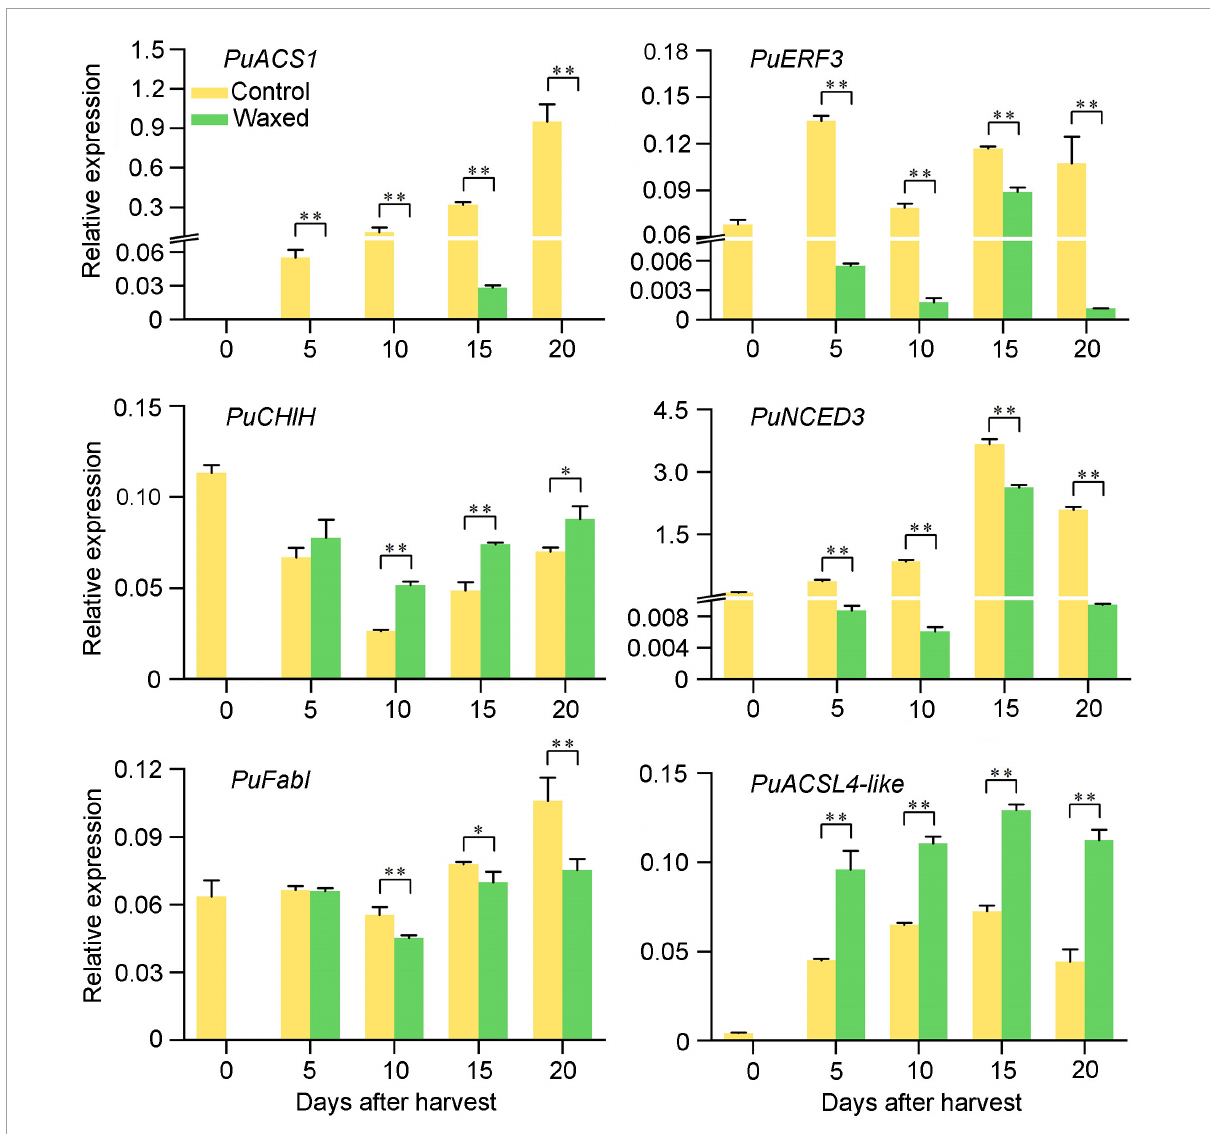
FIGURE7 qRT-PCR validation of six DEGs during pear fruit storage after wax coating treatment. Control, apple fruit not receiving treatment; Waxed, fruit treated with morpholine fatty acid salt fruit wax. The x-axis represents days of storage at room temperature after harvest. For qRT-PCR, three biological replicates were analyzed. The values represent means ± SE. Statistical significance was determined using a Student’s t -test, and ∗ p < 0.05, ∗∗ p <